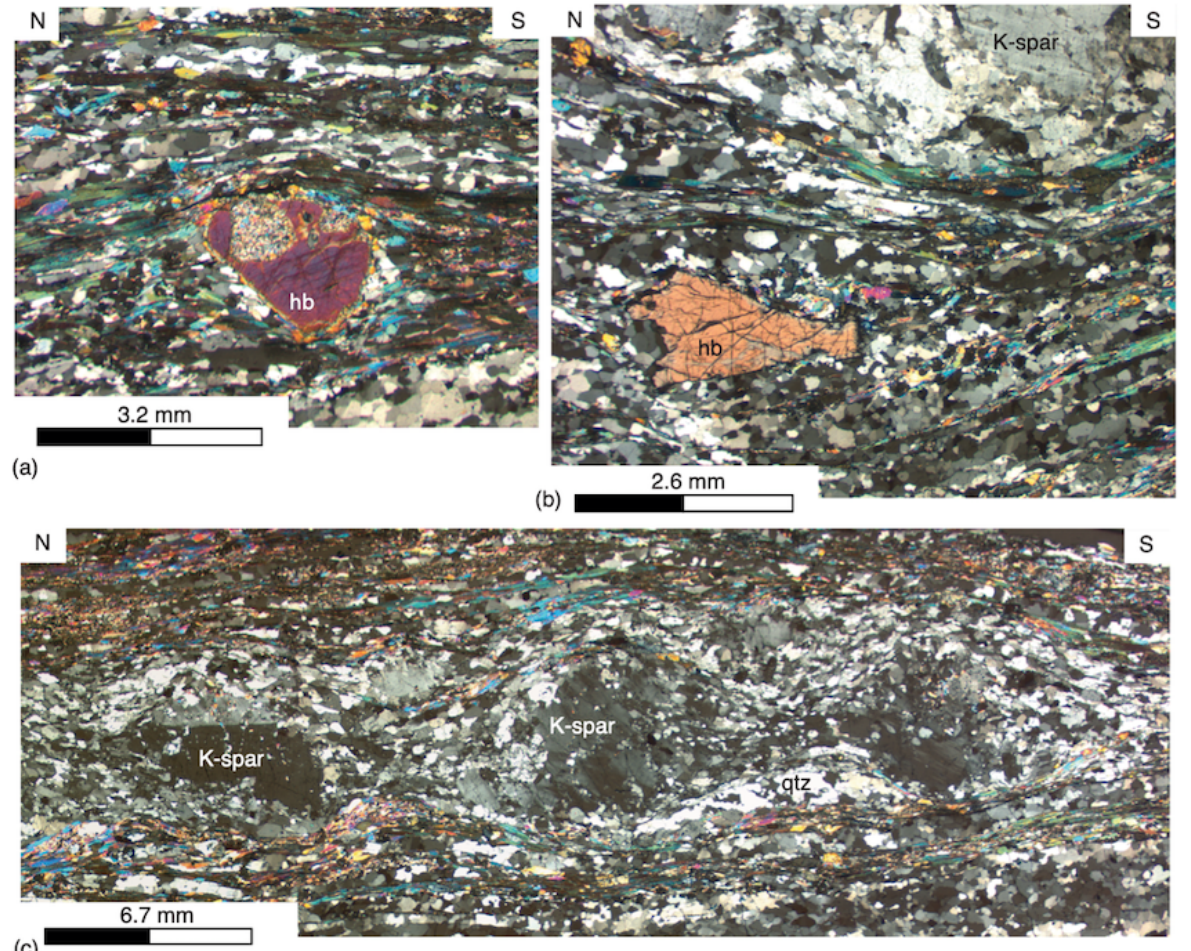
Figure 8. Microstructures analysis on the south Mylopotas headland augengneiss (AG03-03, AG03-04, AG03-05). (a) An older hornblende preserved as large porphyroclasts wrapped by younger, recrystallised white. (b) K-feldspar porphyroclasts with minor recrystallisation limited to their boundaries, and a hornblende xenocryst preserved in a low-strain zone (AG03-04). (c) K-feldspars porphyroclasts overprinted by both the earlier south-directed shear zone and the younger north-directed shear zone, forming “micro boudinage” structures